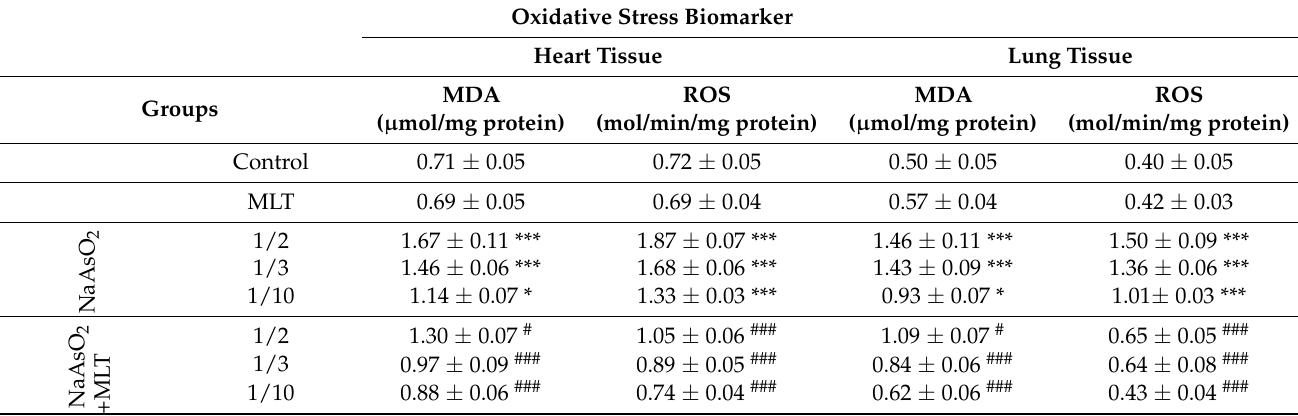
Table 2. Assessment of oxidative stress biomarkers. Oxidative Stress Biomarker Heart Tissue Lung